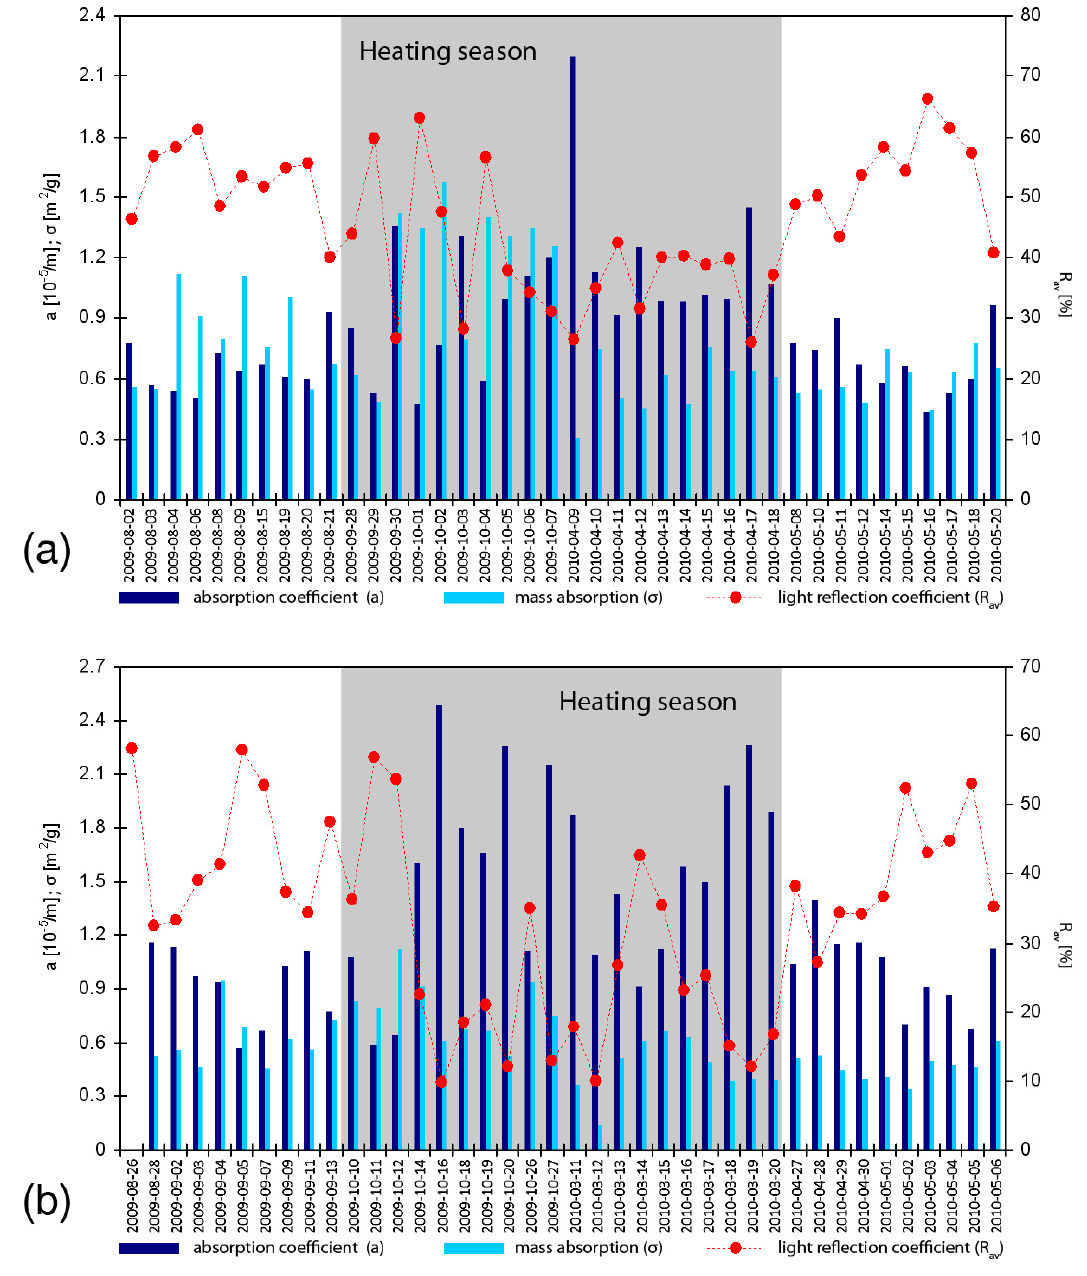
Figure 4. Optical parameters of PM 1 ( a ) and PM 2.5 ( b ) at RB (regional background